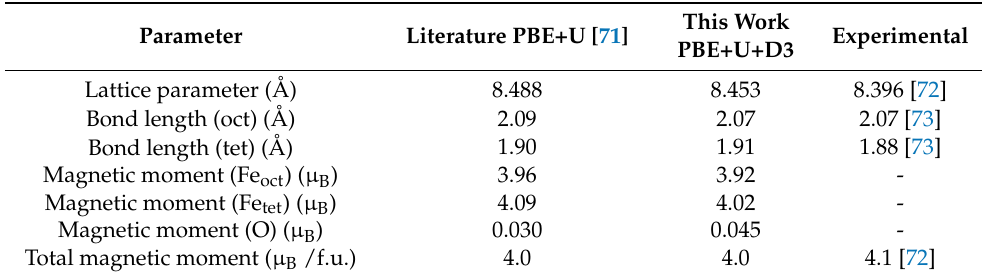
Table 1. Comparison of lattice parameter, O-Fe bond lengths, magnetic moments to previous DFT study of bulk Fe 3 O 4 and experimentally reported values.